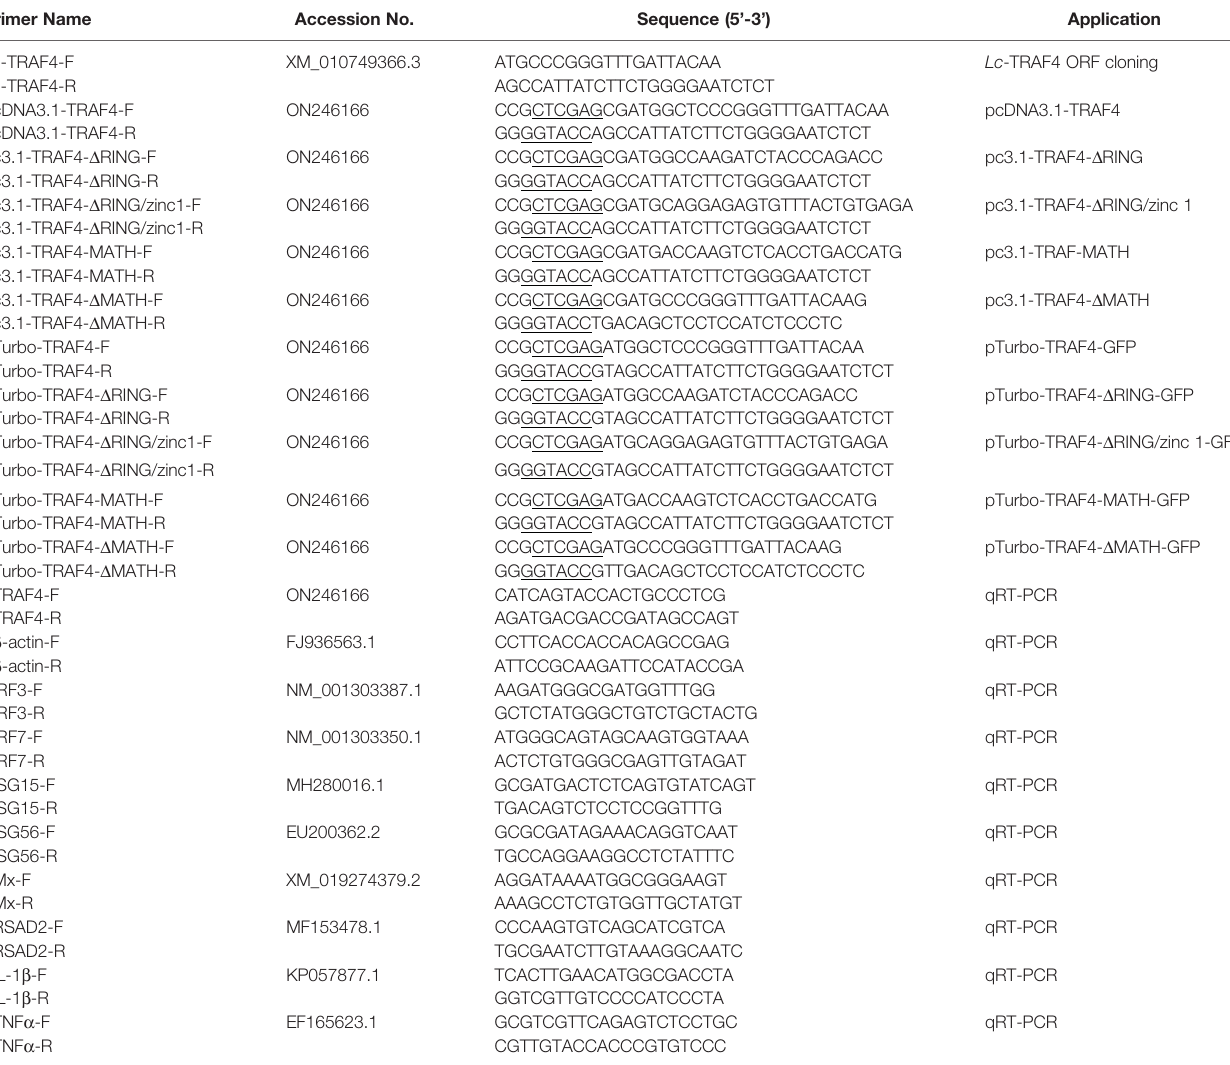
TABLE 1 | Primer sequences used in the present